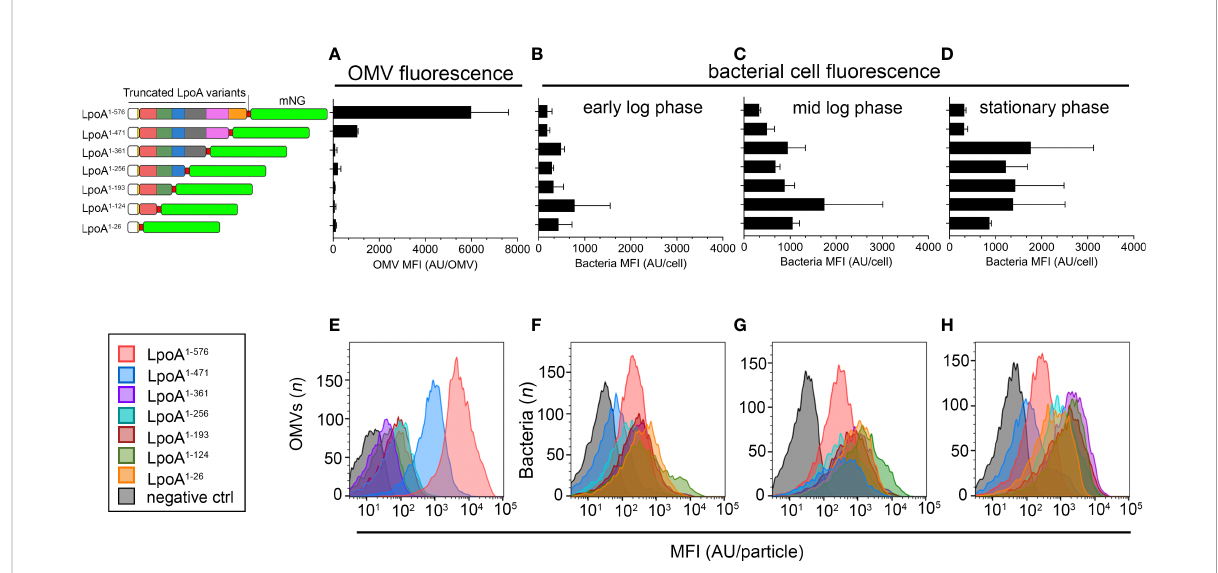
FIGURE 7 Quanti fi cation of single particle fl uorescence in H. in fl uenzae cells and OMVs. (A – H) We cultured H. in fl uenzae Rd strains carrying plasmids with various truncated LpoA-mNeonGreen variants in liquid broth in the presence of IPTG (100 µM), starting with an inoculum of 5 x 10 7 CFU/ml (OD 600nm = 0.03). Cell samples were then taken in early log phase (OD 600nm = 0.1), mid log phase (OD 600nm = 1) and stationary phase (o/n cultures, OD 600nm ≈ 3.0), washed thrice in PBS followed by measurement of cellular fl uorescence. OMVs were isolated from the corresponding stationary phase cultures. (A) Measurement of mean fl uorescence intensity (MFI) in OMVs puri fi ed from strains ectopically expressing the LpoA- mNG variants are shown to the left. (B – D) Accumulation of LpoA-mNG signals over the course of the growth curve in cells producing variants lacking the C-terminus. Culture conditions were as stated above. The mean and SD from two independent experiments are plotted. (E – H) One representative histogram from each experiment is